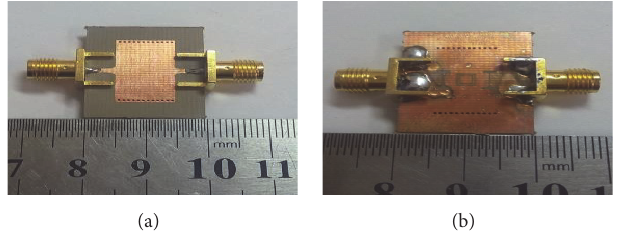
Figure 7: The top view (a) and the bottom view (b) of the fabricated filter.